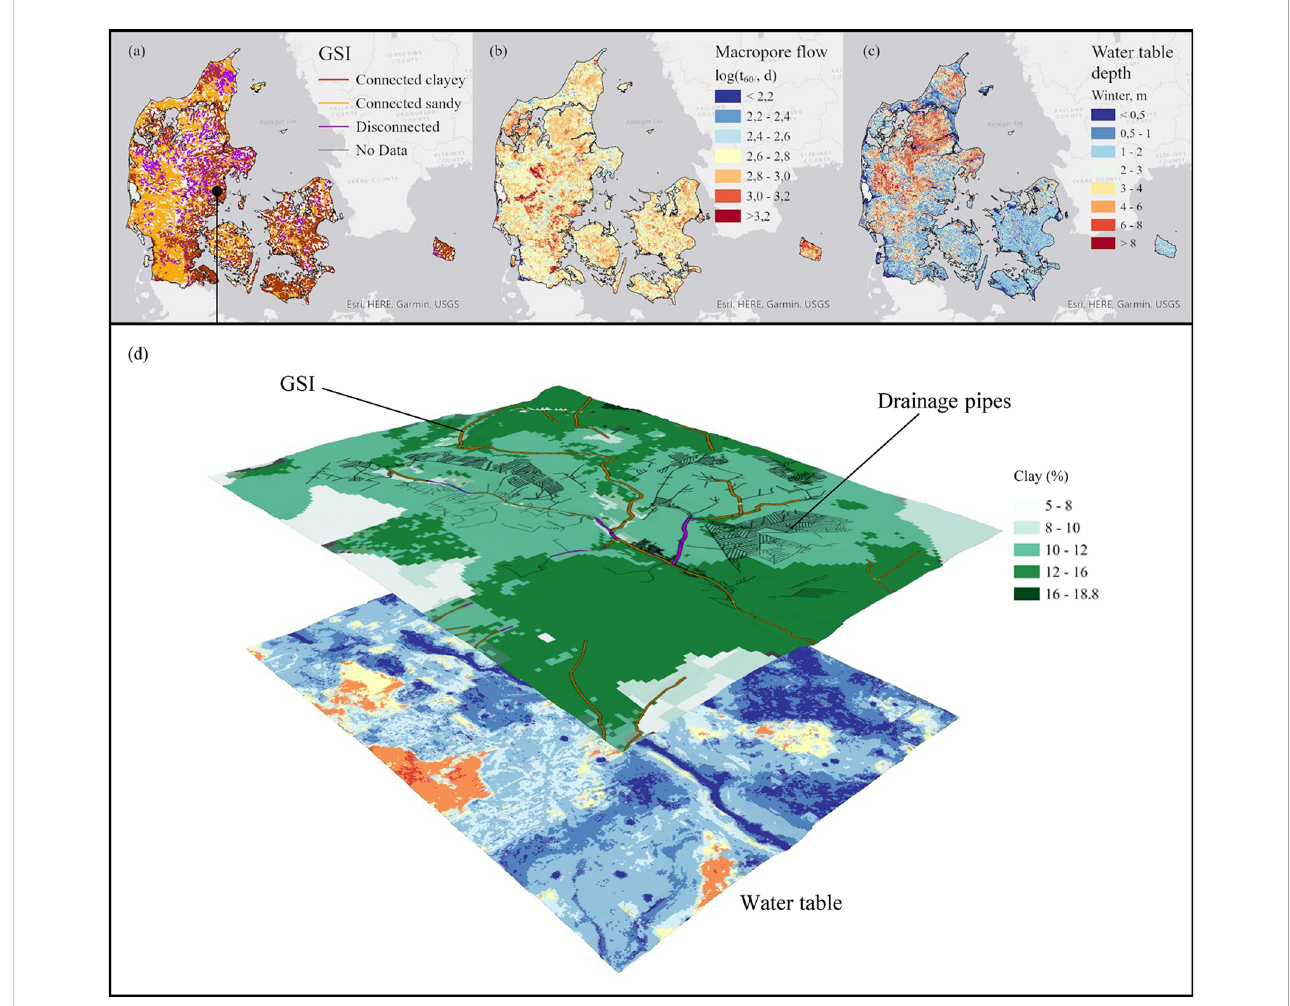
FIGURE 4 Water dynamics in Denmark represented by the maps of (A) groundwater surface interaction-GSI, (B) macropore fl ow, and (C) water table for the winter season. The selected area is the Fensholt region (D) and highlights the GSI and pre-existing drainage pipes over the clay map (%) and the water table for winter